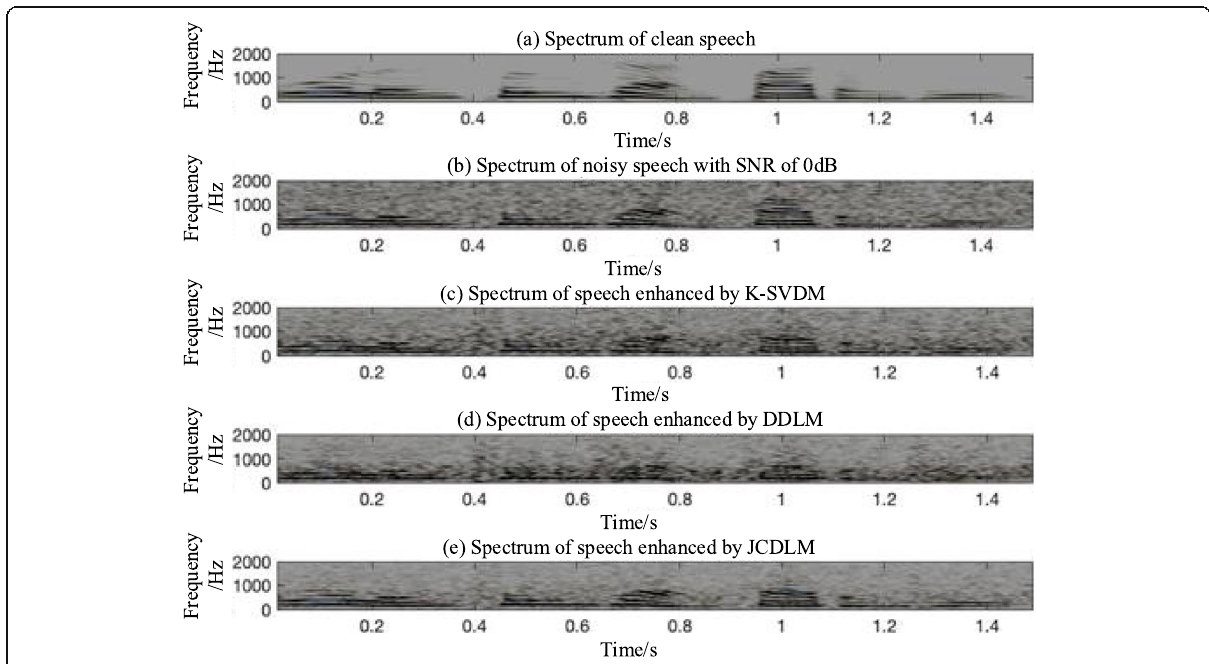
Fig. 10 Spectrum enhanced of different algorithms under 0-dB white